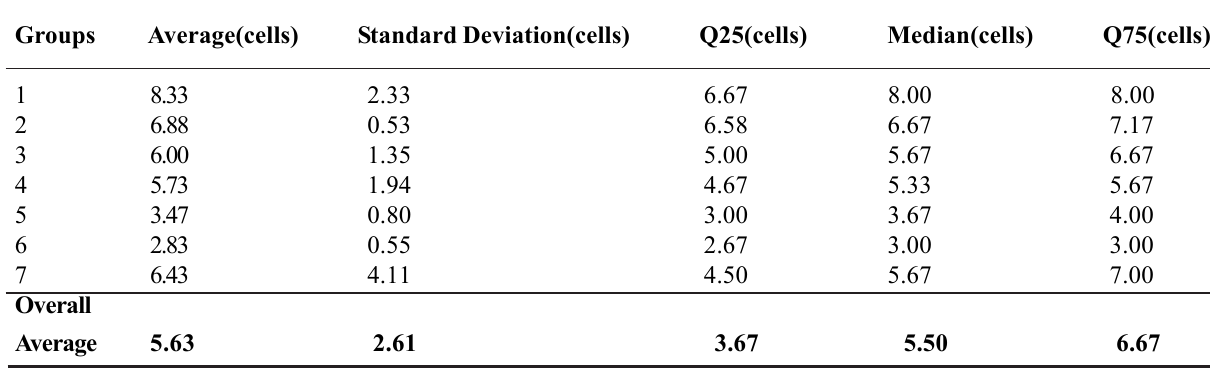
TABLE 3 — Measures of mononuclear cells (cells), with Arithmetical Average, Standard Deviation, Q25, Median, Q75 of all Groups, individually and globally.